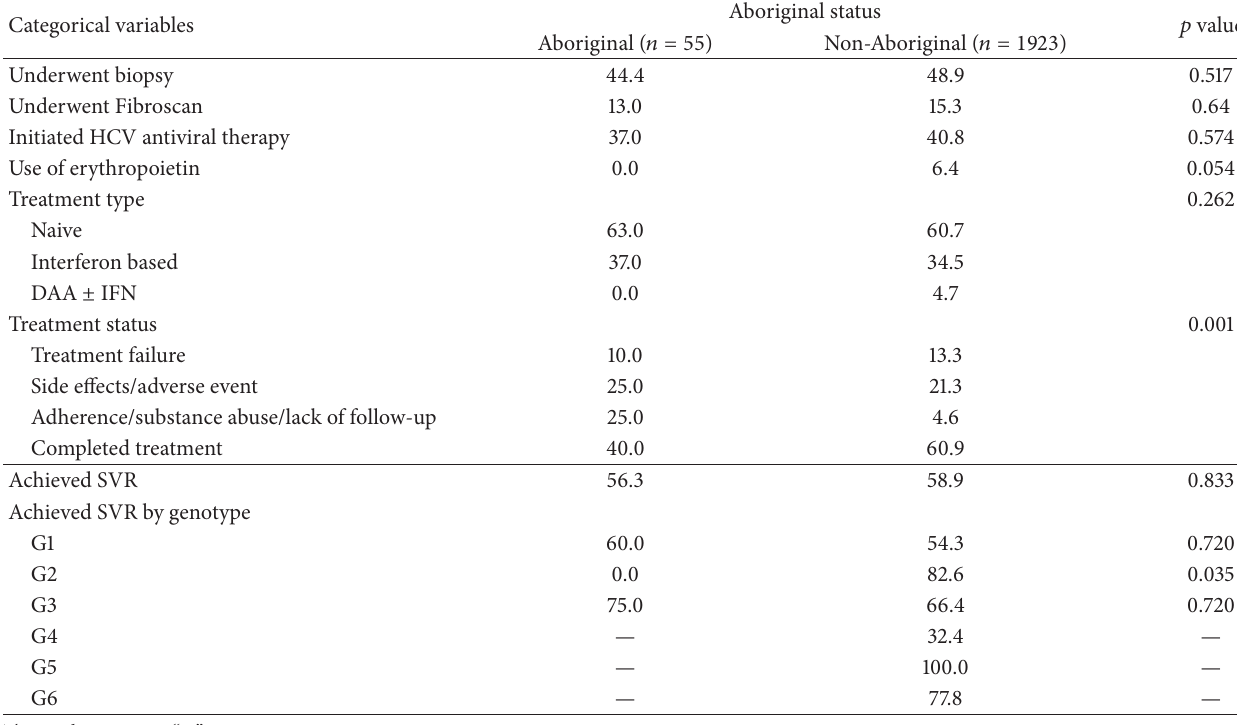
Table 2: Categorical demographic characteristics and indicators of HCV management, treatment, and outcomes according to Aboriginal status.